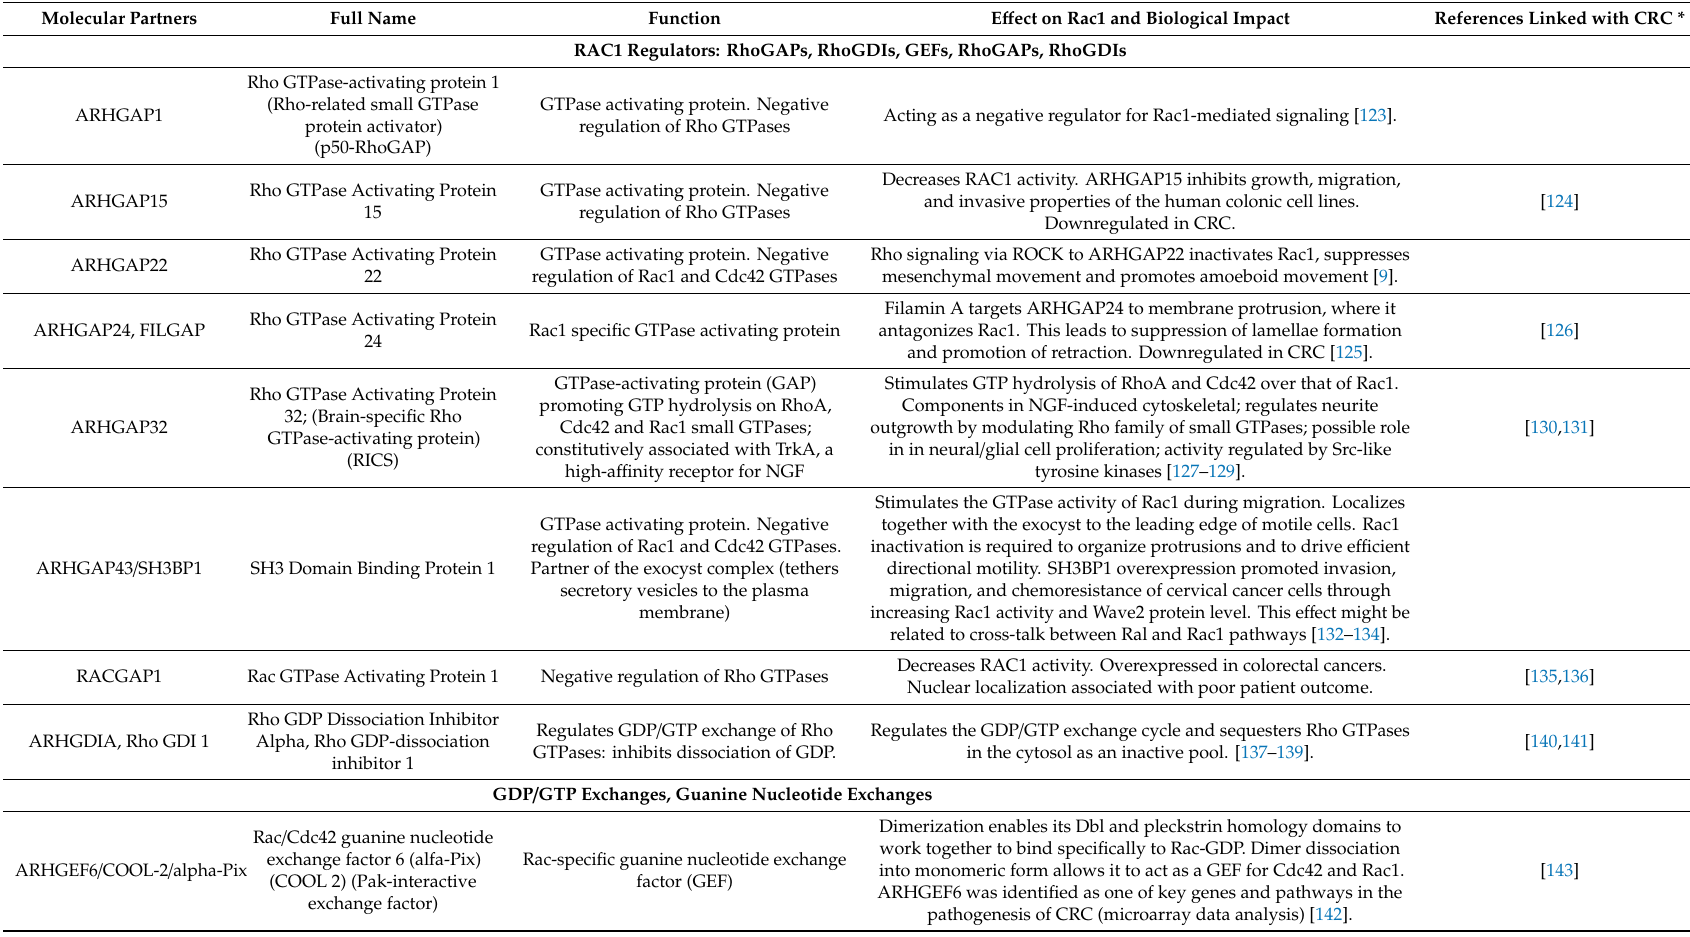
Table 2. Upstream e ff ectors; RhoGAsP, RhoGDIs,